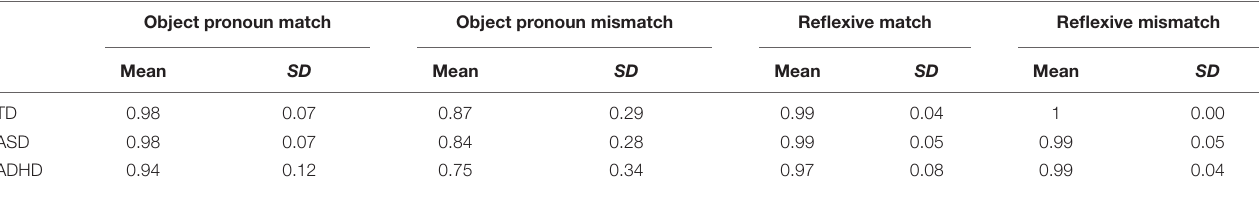
TABLE 2 | Mean proportions correct responses and standard deviations per group and per condition in the comprehension